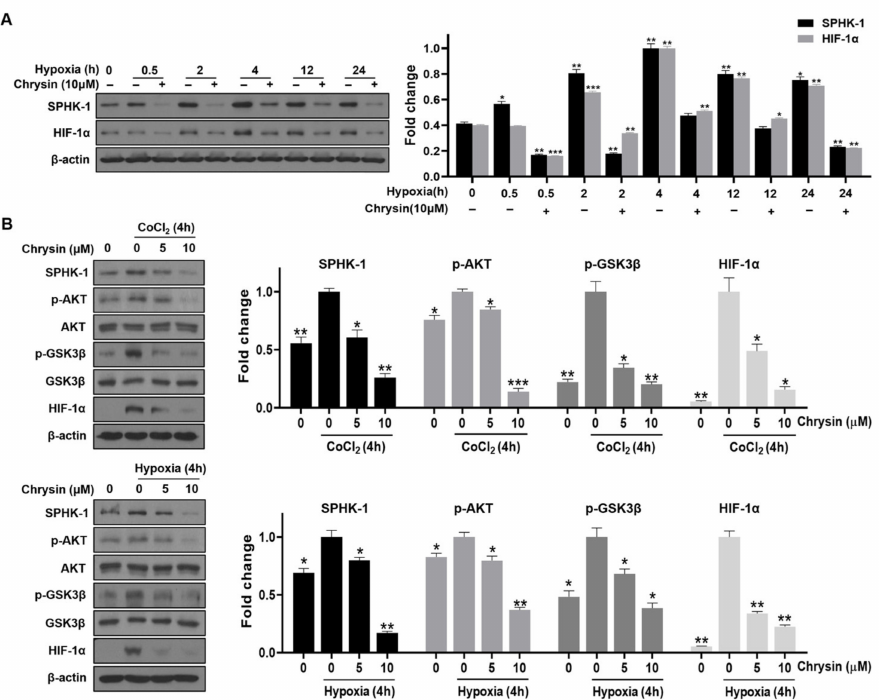
Figure 2. Effects of chrysin on the expression of SPHK-1 and its signaling proteins in hypoxic PC-3 cells. ( A ) Cells were treated with 10 µ M chrysin for 0, 0.5, 4, 12, and 24 h under hypoxia. Western blotting was performed to determine SPHK-1 and HIF-1 α expression. Quantitative protein levels are shown in the bar graph as mean ± SD for the duplicate. * p < 0.05, ** p < 0.01, and *** p < 0.001 compared with the hypoxia control. ( B ) Representative Western blot images and relative densitometric bar graphs of SPHK-1, AKT, p-AKT, p-GSK3 β , GSK3 β , and HIF-1 α . Cells were treated with chrysin for 4 h under hypoxia or with the hypoxic mimic CoCl 2 . Western blotting was performed to determine SPHK-1, AKT, p-AKT, p-GSK3 β , GSK3 β , and HIF-1 α expression. Bar graphs presented as a fold change of control. * p < 0.05, ** p < 0.01, and *** p < 0.001 when compared to the hypoxia